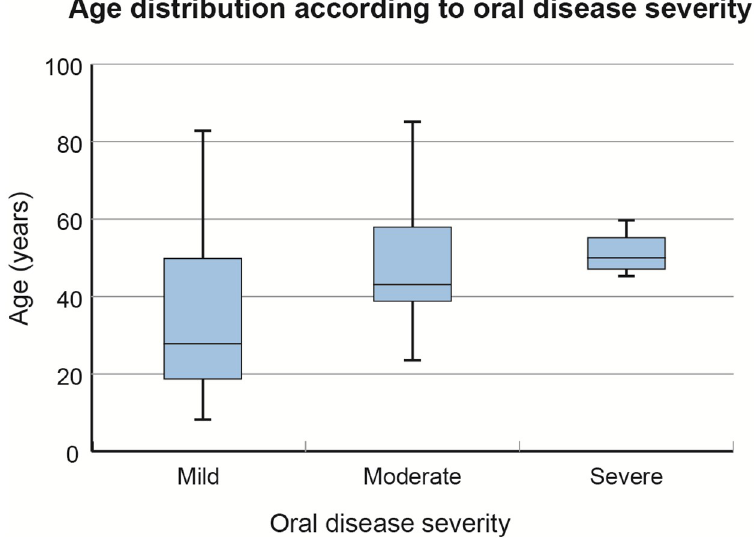
Fig 1. Boxplot showing age distribution according to oral disease severity. The bold lines represent the median values, the boxes indicate the interquartile range, and the whiskers represent the minimum and maximum values. Please, refer to Table 1 for the score used to categorize the severity of oral